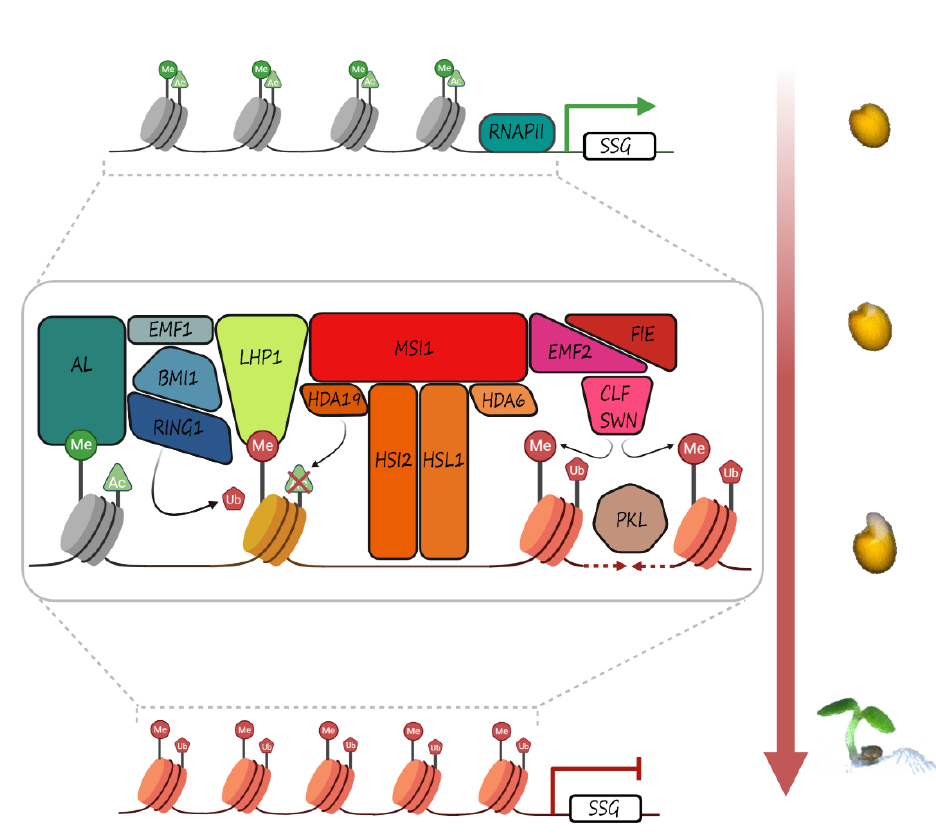
Figure 2. Schematic model of the molecular complexes involved in the control of seed-specific genes. The model depicts the PRC1 and PRC2 complexes and histone deacetylases HDA6 and HDA19 on the promoter of seed-specific genes (SSG). The interacting proteins AL-PHD, HSI2, and HSL1 are also shown. The H3K4me3 activation marker is indicated with green circles, while the H3K27me3 repressing one is indicated with red ones; the acetylation activating marker is shown as a green triangle; H2Aub is reported as a red pentagon. On the right the developmental steps are also reported.